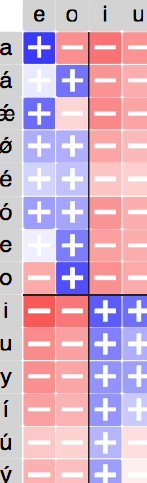
Figure 4: PhonMatrix visualisation of pre-decay Old Norwegian harmony in